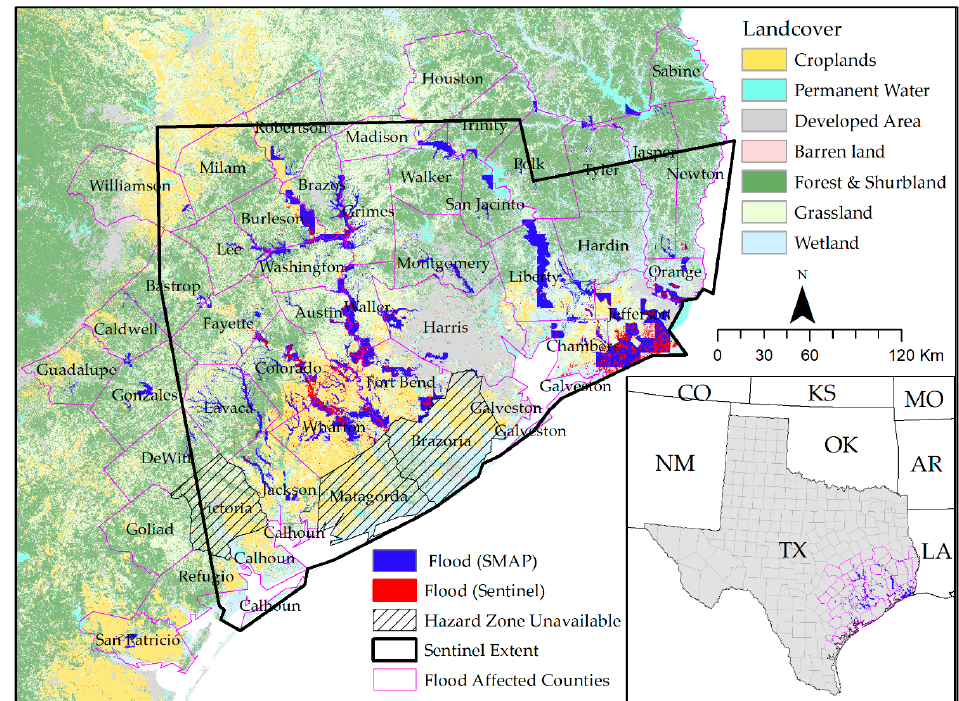
Figure 4. Inundation area extracted from SMAP and Sentinel-1 of the Houston Flood superimposed over CDL.